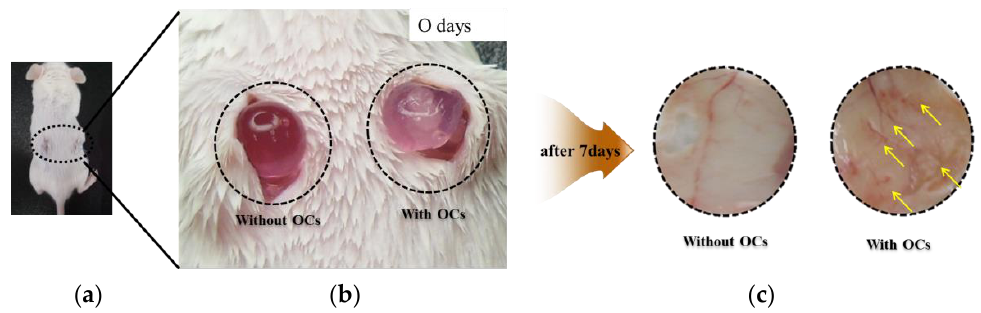
Figure 8. In vivo evaluation of the oxygen-supplied capsule. The transplanted capsules on the back of an Jcl:ICR mouse ( a ), the magnified images of the capsules at day 0 ( b ), and the significantly increased angiogenesis by the oxygen-supplied capsule at day 7 ( c ).